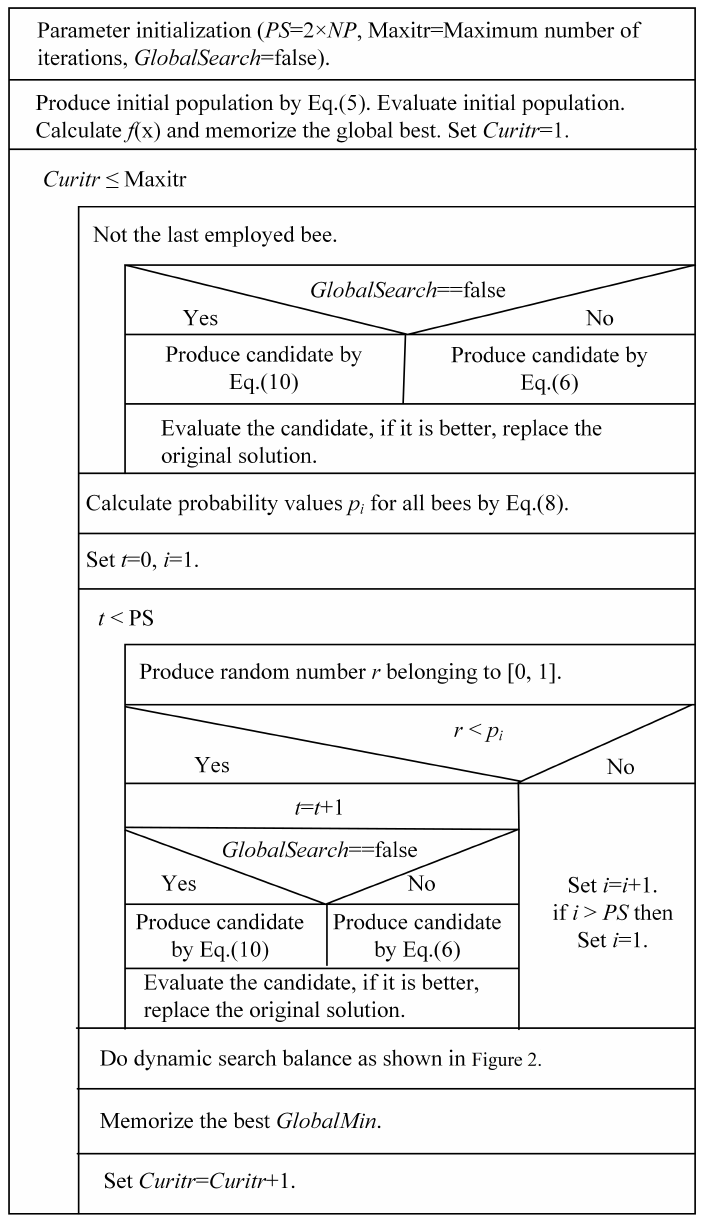
Figure 3. N-S Diagram of dpABC